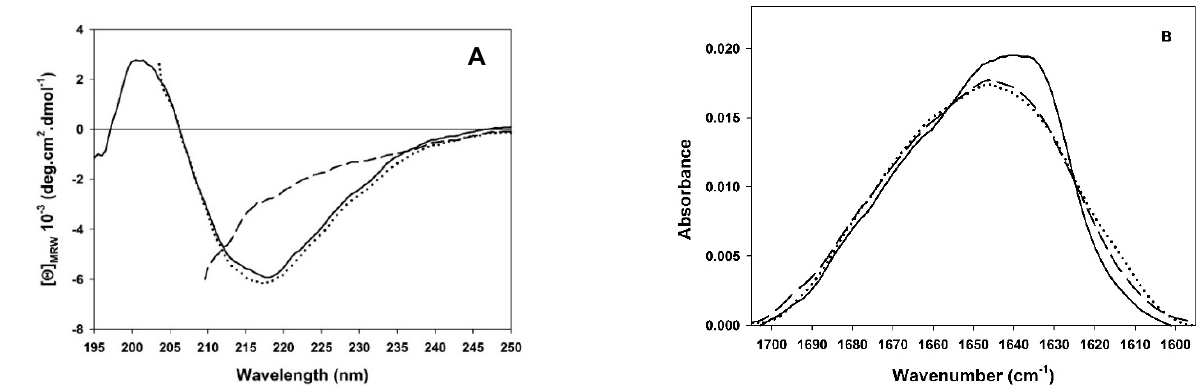
Figure 2. ( A ) Far-UV CD spectra of native (continuous line), unfolded in 2.5 M GdmCl (broken line) and refolded from 2.5 to 0.25 M GdmCl (dotted line) PemA. ( B ) FTIR spectra of PemA under native (33 MPa; continuous line), unfolding (1100 MPa; broken line), and refolding (i.e., 41 MPa after decompression; dotted line) conditions, with data normalized using the area under the amide I’ band equal to 1.